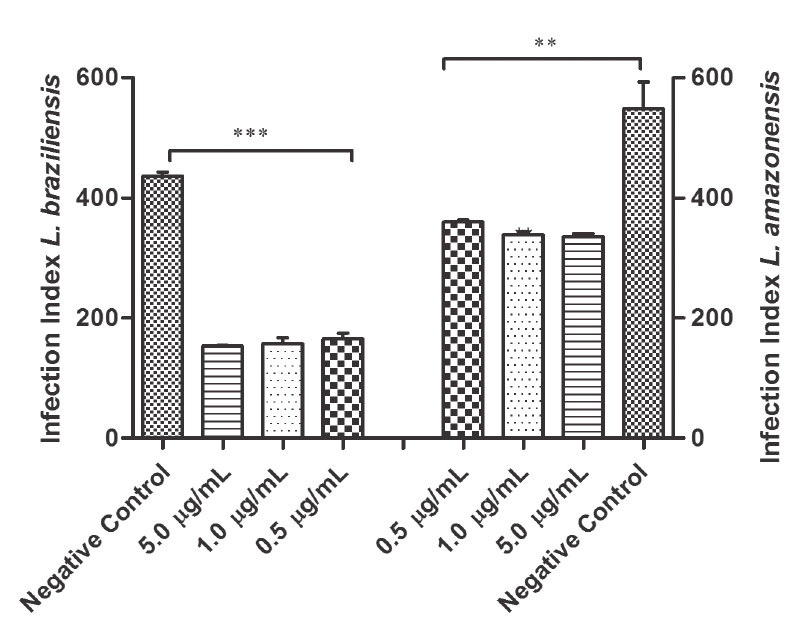
Figure 1 - Effect of Casearia sylvestris extract on L. braziliensis and L. amazonensis infected macrophages. Peritoneal macrophages previously infected with L. braziliensis or L. amazonensis promastigotes in the stationary growth phase were exposed to the compounds for 72h and the results were expressed as the infection index (percentage of infected macrophages x mean number of parasites per cells). The test considered the mean of two assays performed in duplicate. Differences were regarded as significant when p < 0.0001 (***) and p < 0.001